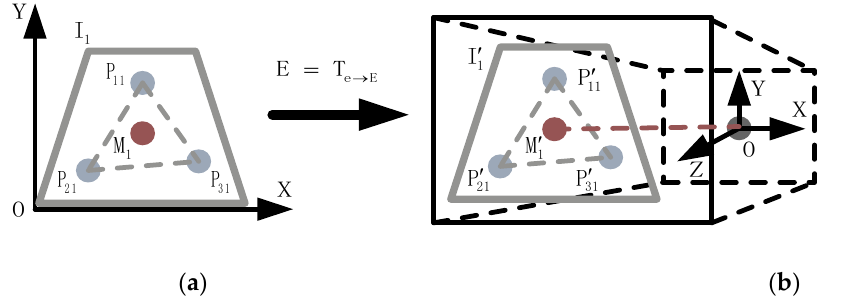
Figure 2. Coordinate transformation. ( a ) US image coordinate system; ( b ) 3D reconstruction coordi- nate system.